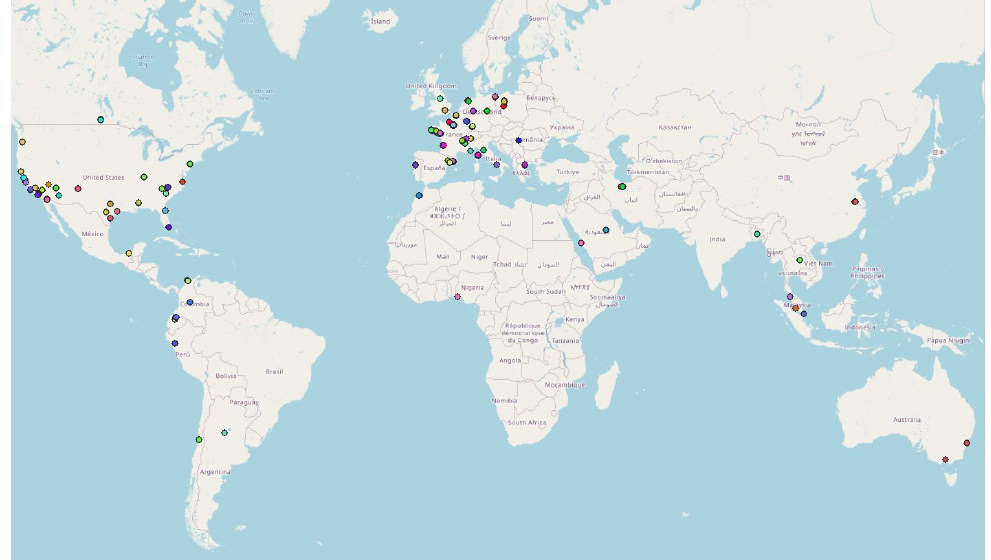
Figure 10. Representation of the 227 clusters with at least 3 contributors found around the globe using the DBSCAN approach (1 point is a cluster; cluster points may overlay; the color of each cluster is